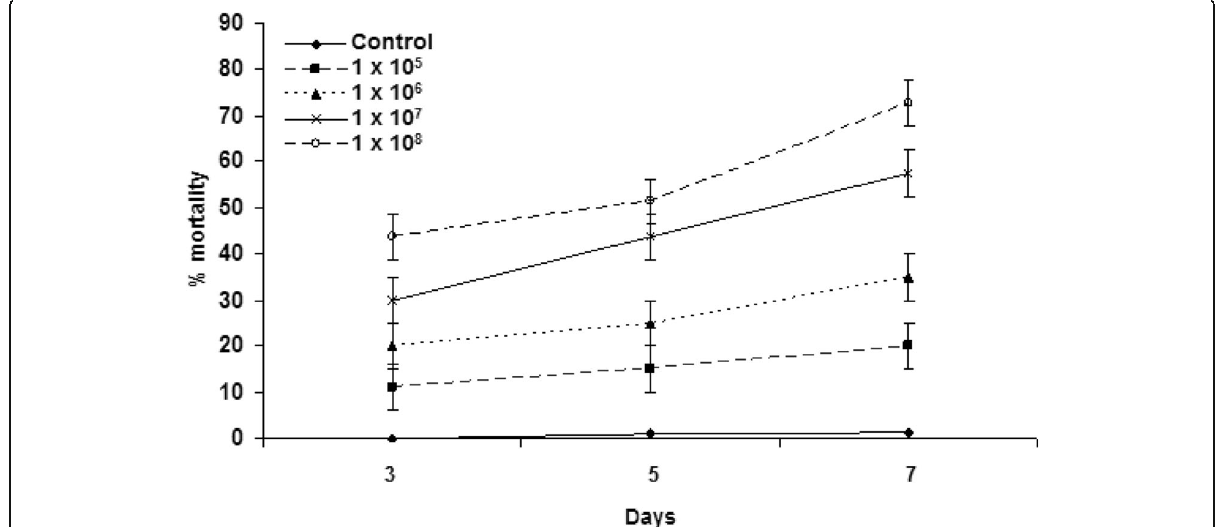
Fig. 3 Lethal effect of Verticillium lecanii isolate to Tetranychus urticae after treatment with conidial suspensions at concentration 1 × 10 5 , 1 × 10 6 ,